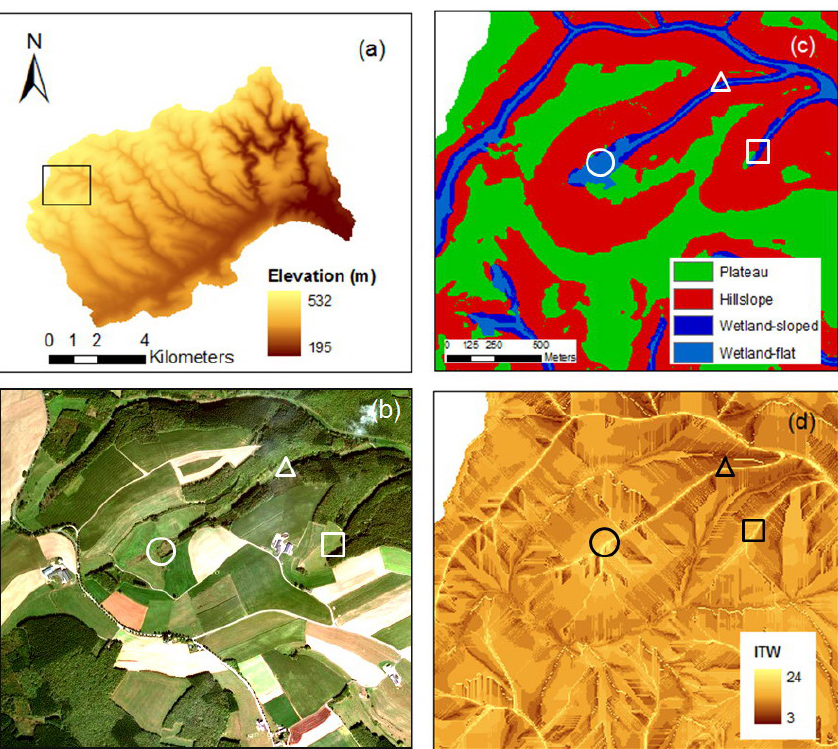
Fig. 13. (a) Location of a selected headwater of the Wark (b) aerial photo of the headwater (c) categorized landscapes using the best model, M SHopt (d) topographical wetness index ( I TW ). For better orientation, shapes ( 4 , (cid:13) , (cid:3) ) indicate identical positions on the maps (b) , (c) and (d) .